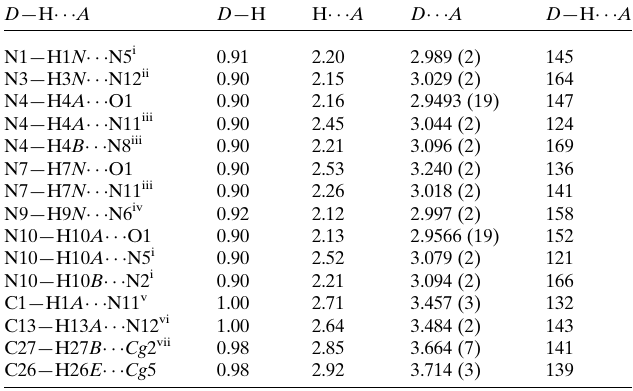
Table 1 Hydrogen-bond geometry (A˚ , (cid:3)